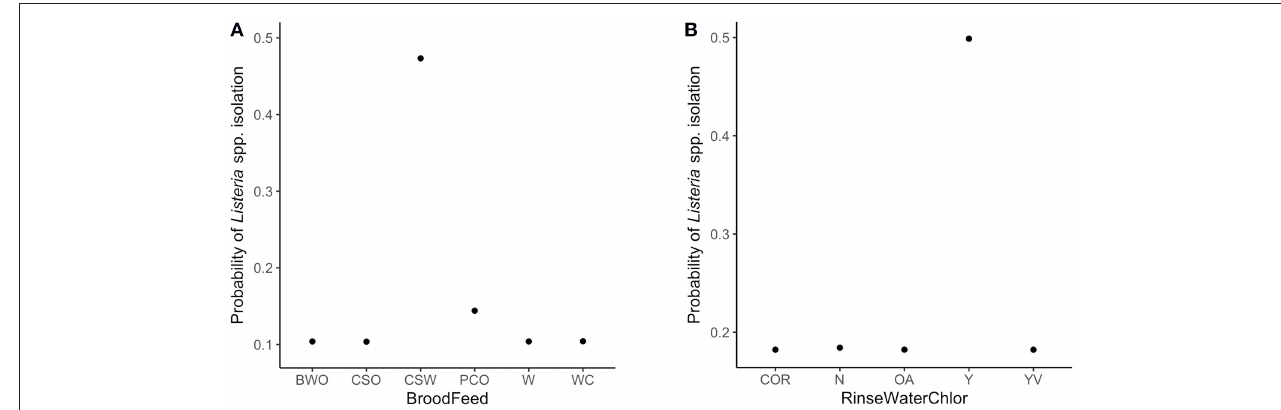
FIGURE 4 | Partial dependency plots (PDPs) for the two most important predictors in the whole carcass rinse (WCR) final product random forest model. (A) Brood feed refers to up to the top 3 sources of protein in the brood feed. Ingredients include: barley (B), corn (C), oats (O), wheat (W), soy (S), cotton seed mill (M), peas (P).